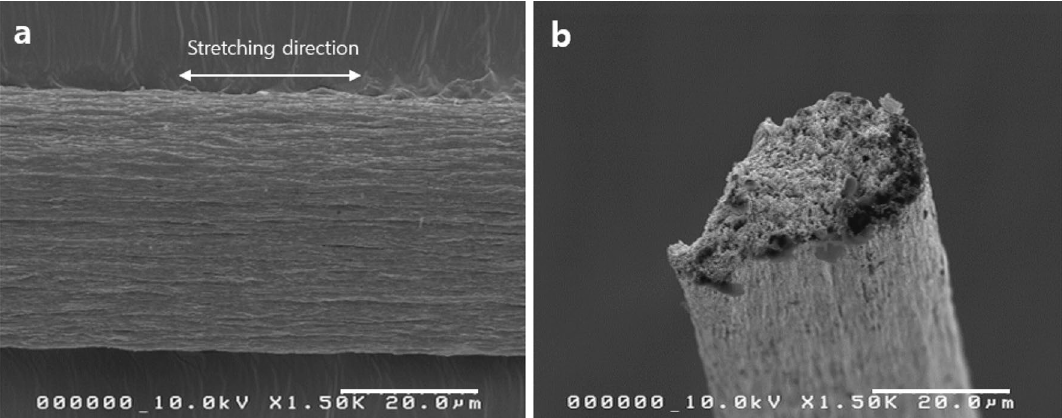
Figure 8. The SEM images of the continuously processed CNGO hybrid filament: ( a ) surface and ( b ) fractured surface.